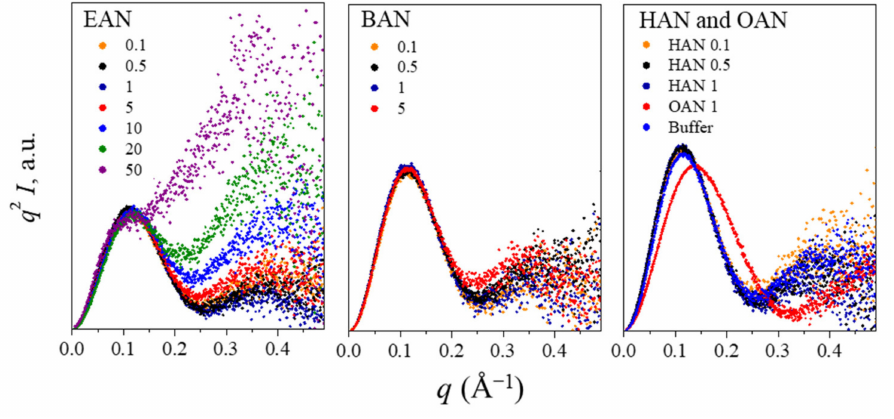
Figure 5. Normalized Kratky plots of lysozyme in PIL aqueous solutions (i.e., EAN, BAN, HAN and OAN), along with those in a buffer solution for